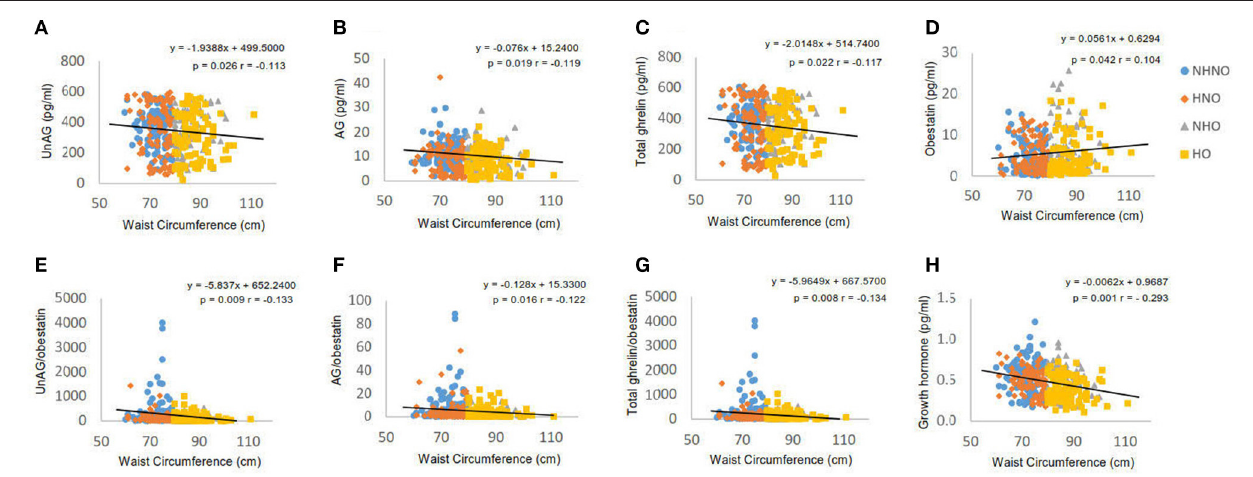
FIGURE 3 | Correlation analyses of waist circumference to ghrelin gene products, growth hormone and ratios of two forms of ghrelin to obestatin. (A) Correlation between waist circumference and serum level of unacylated ghrelin. (B) Correlation between waist circumference and serum level of acylated ghrelin. (C) Correlation between waist circumference and serum level of total ghrelin. (D) Correlation between waist circumference and serum level of obestatin. (E) Correlation between waist circumference and the ratio of unacylated ghrelin to obestatin in serum. (F) Correlation between waist circumference and the ratio of acylated ghrelin to obestatin in serum. (G) Correlation between waist circumference and the ratio of total ghrelin to obestatin in serum. (H) Correlation between waist circumference and serum level of growth hormone. Pearson’s correlation analyses were performed. Statistical significance was accepted at p < 0.05. Circle refers to the data of non-hypertensive non-centrally obese subjects. Rhombus refers to the data of hypertensive non-centrally obese subjects. Triangle refers to the data of non-hypertensive centrally obese subjects. Square refers to the data of hypertensive centrally obese